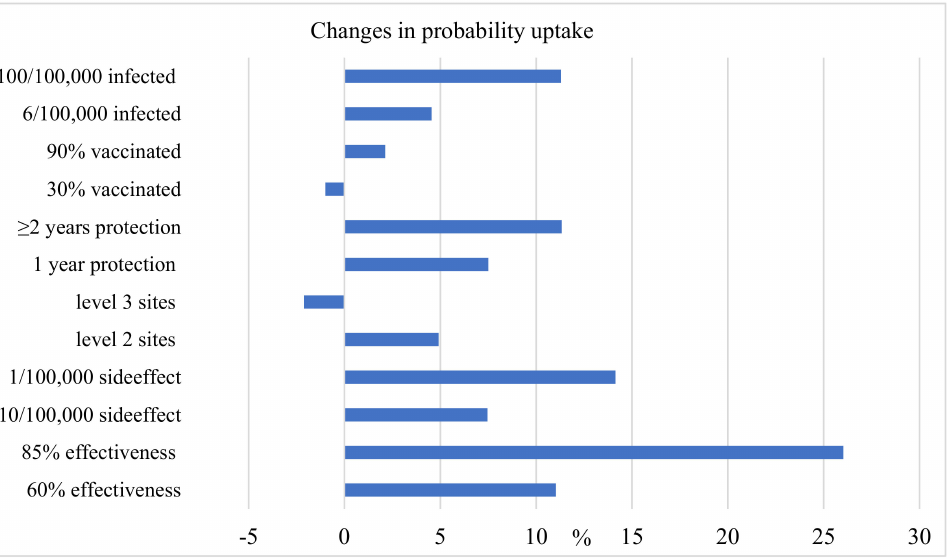
Figure 1. Changes in probability